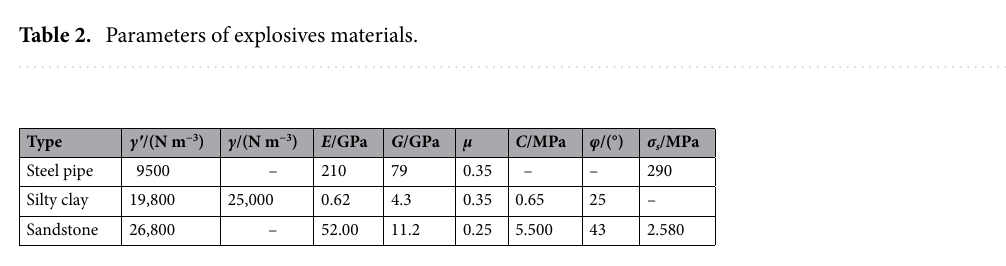
Table 3. Physical and mechanical parameters of steel pipeline and soil and